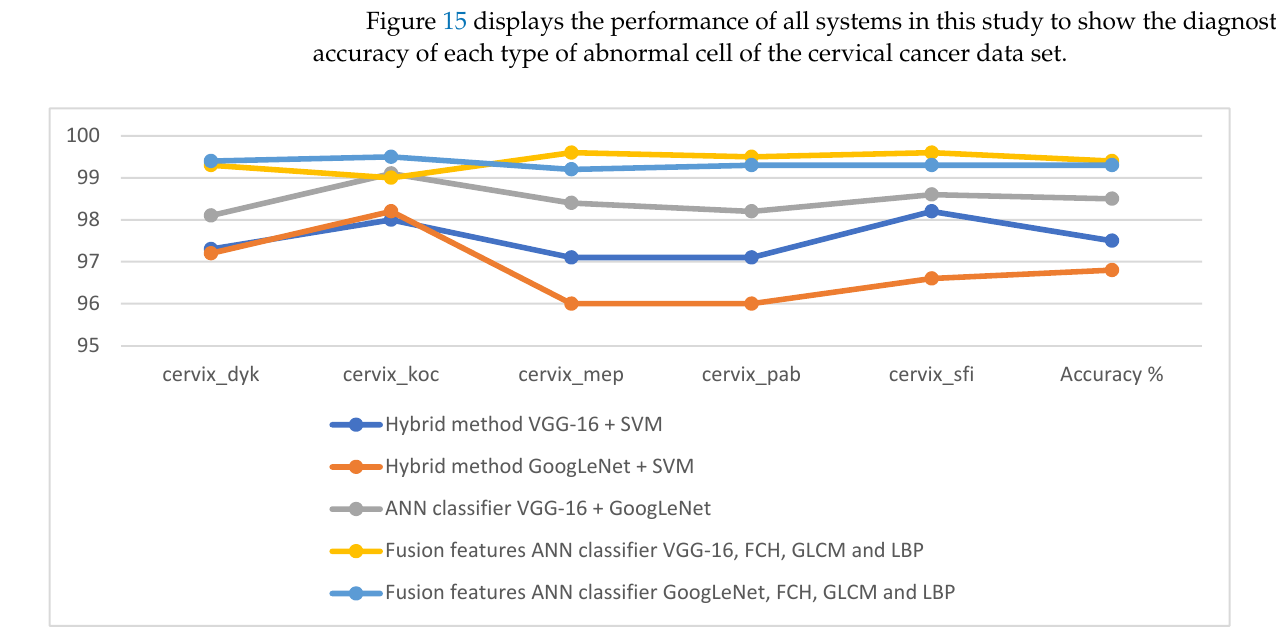
Figure 15. Presentation of the performance of all proposed approaches for diagnosing abnormal cervical cells.